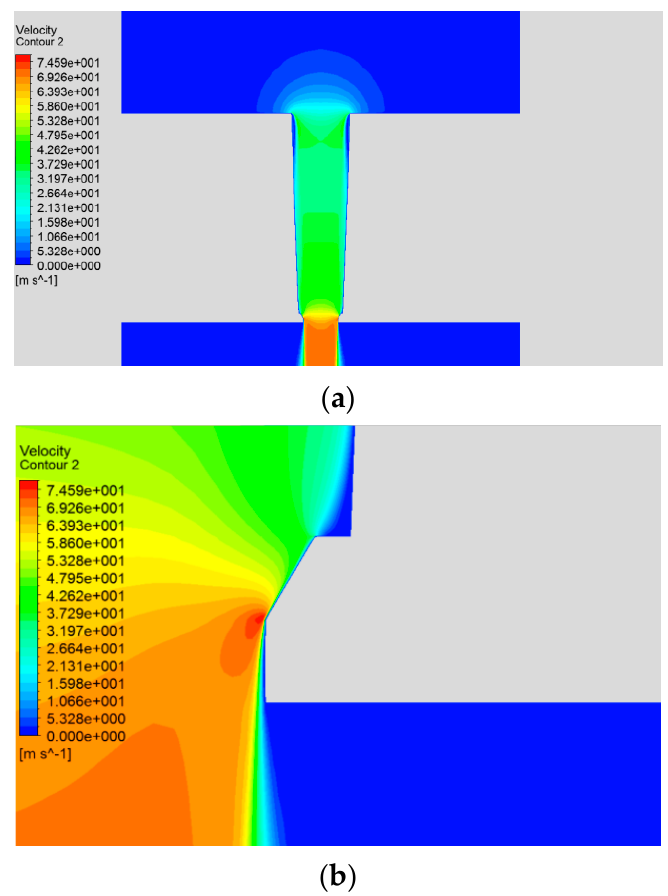
Figure 14. Velocity contours on the mid-section of the inflow duct. (a) Overall view and (b) detail of outlet section.